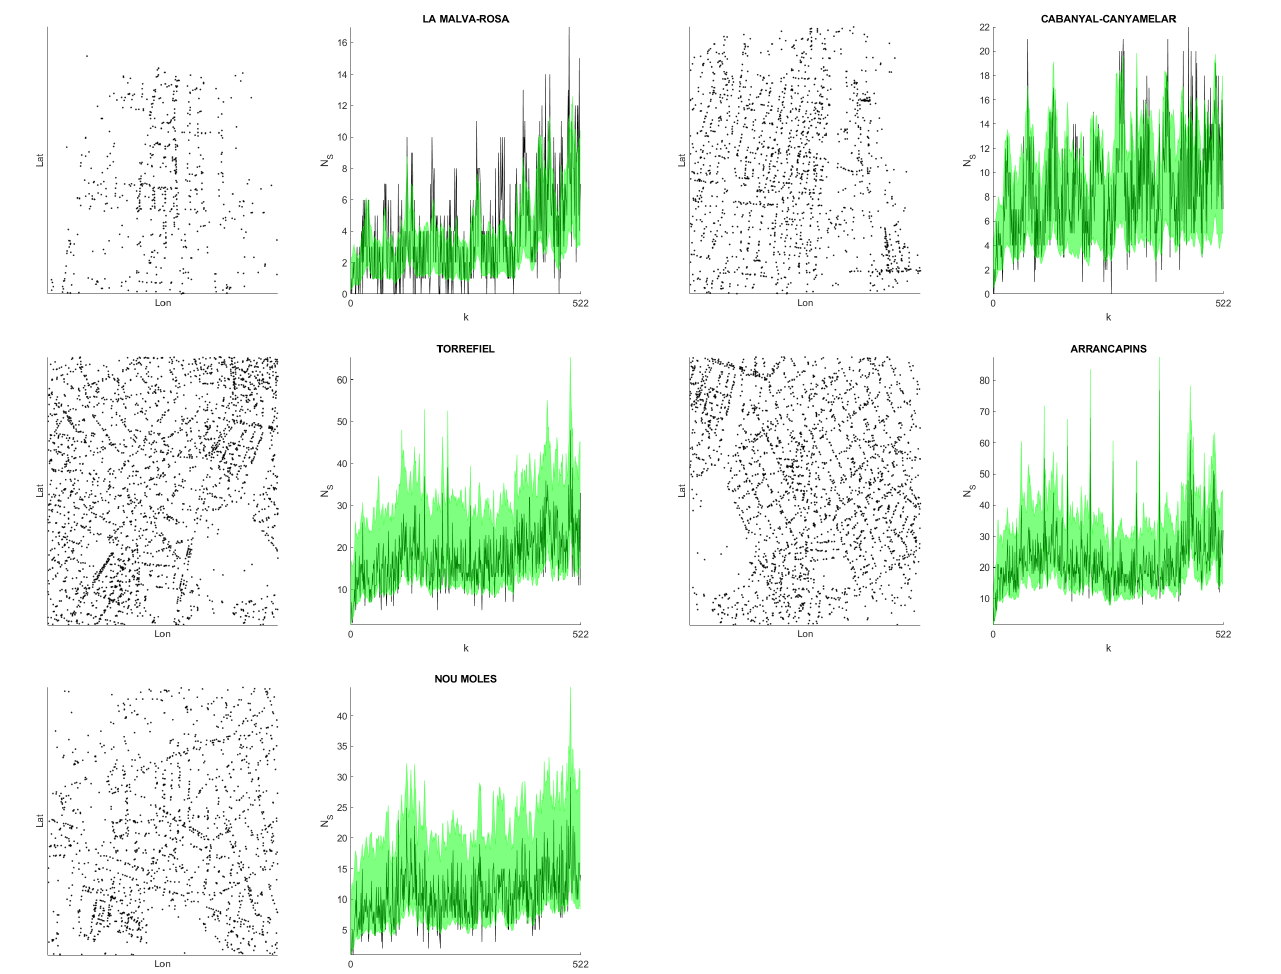
Figure 18. Model fitting for five different neighbourhoods in Valencia. For each neighbourhood, the left panel shows the spatial distribution of the emergency calls with a buffer of 100 m, and the right panel displays the weekly counts (black) with their corresponding 90% fitted confidence intervals